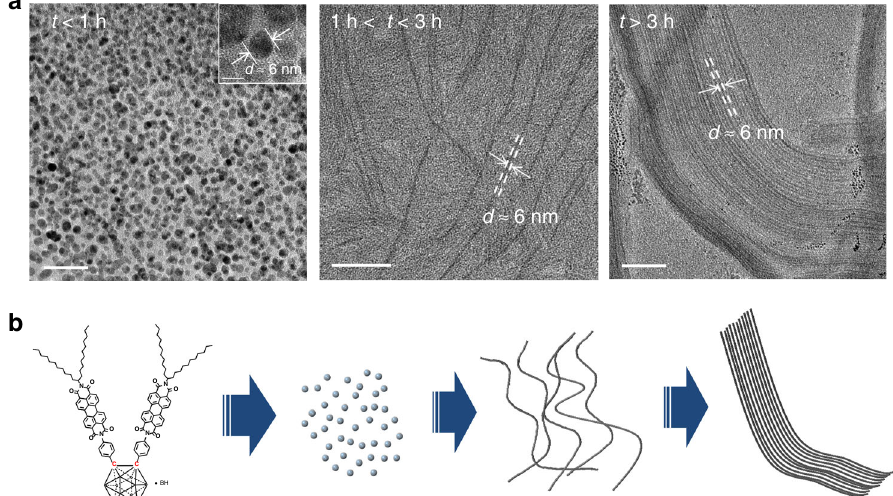
Fig. 2 Self-assembly of PBI-CB in solution. a TEM images of the self-assembled structures of PBI-CB at different times in a mixture solvent of dioxane:water ( V : V = 92.5:7.5). It is seen that initially, the molecule of PBI-CB self-assembled into nanoparticles ( t < 1 h), then nano fi bers (1 h < t < 3 h), and fi nally nanoribbons ( t > 3 h), scale bar: left, 20 nm; the insert of the left, 5 nm; middle and right, 100 nm. b Schematic representation of self-assembly process of